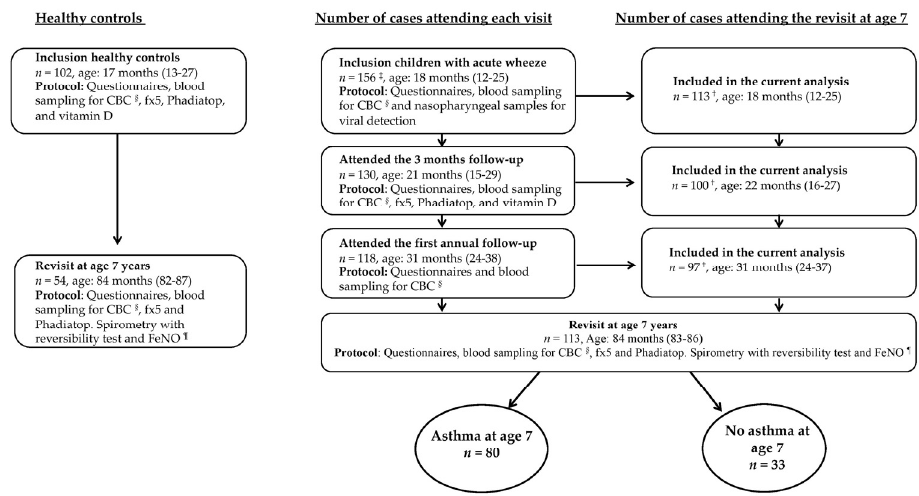
Figure 1. Flow-chart of number of controls and cases that attended the different follow-ups and sample collections at each visit. Age in months presented as medians with inter-quartile ranges (IQR). † Number of cases that attended the revisit at age 7 years. ‡ Two cases were excluded after inclusion because of prematurity and pseudo croup. § CBC = complete blood count. ¶ Nitric oxide in exhaled air.